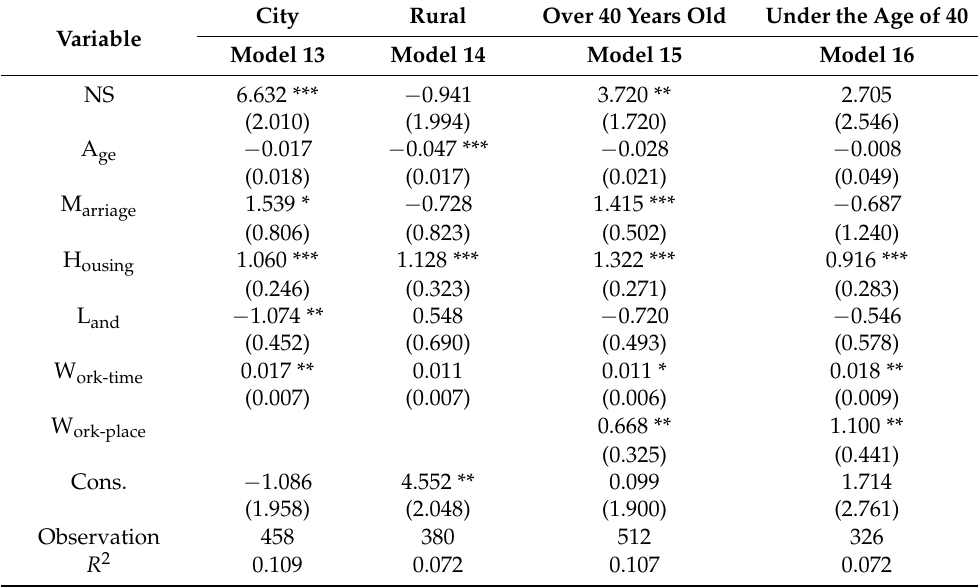
Table 5. Non-cognitive skills and farmers’ entrepreneurship performance: regression results of heterogeneity.